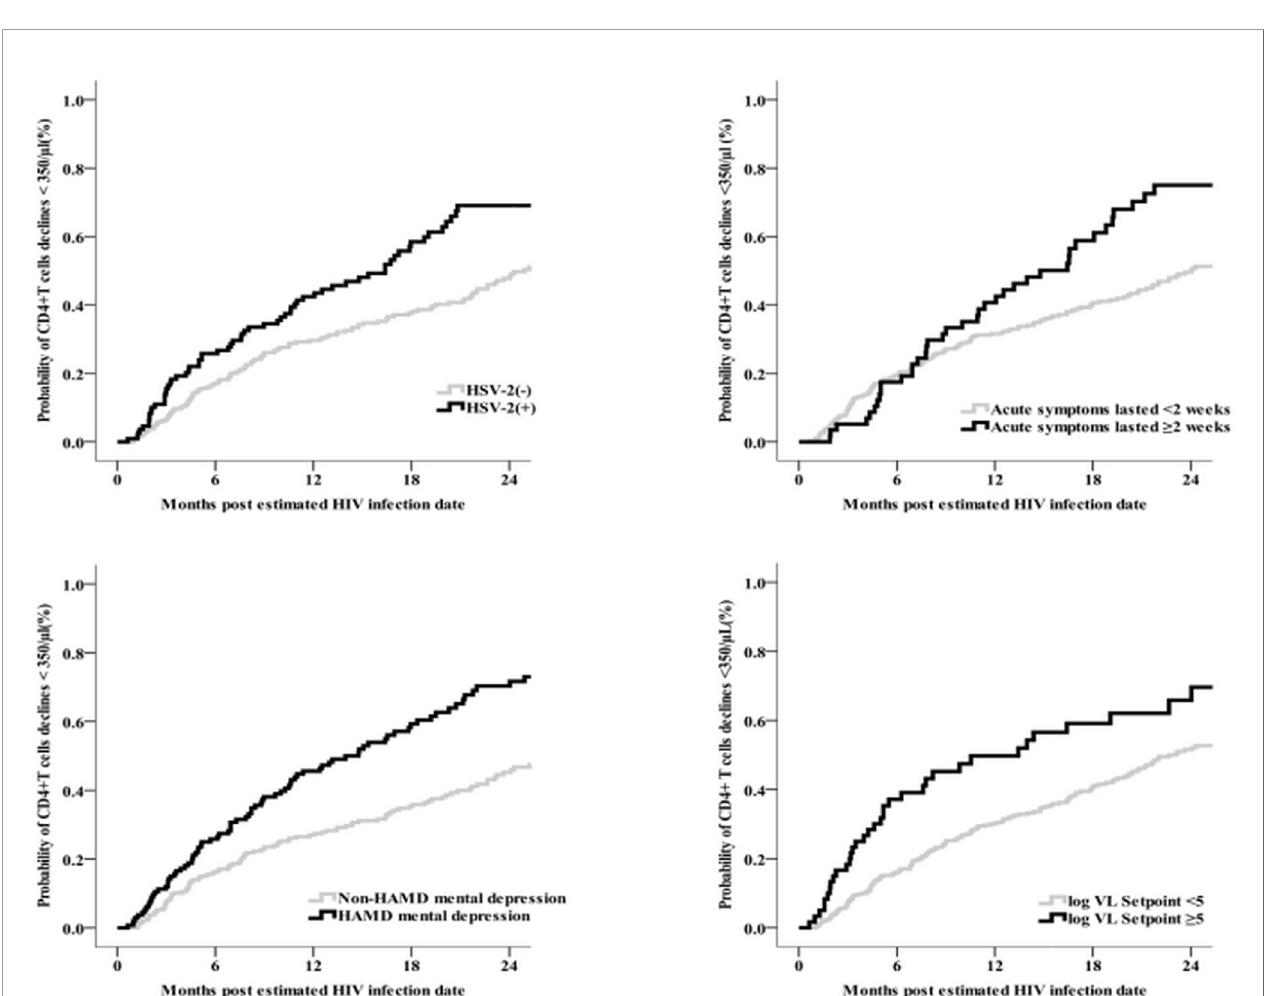
FIGURE 4 | The relationship graphs of predictors of HSV-2, acute symptoms lasted time, depression and CD4<350/ m l event (N =